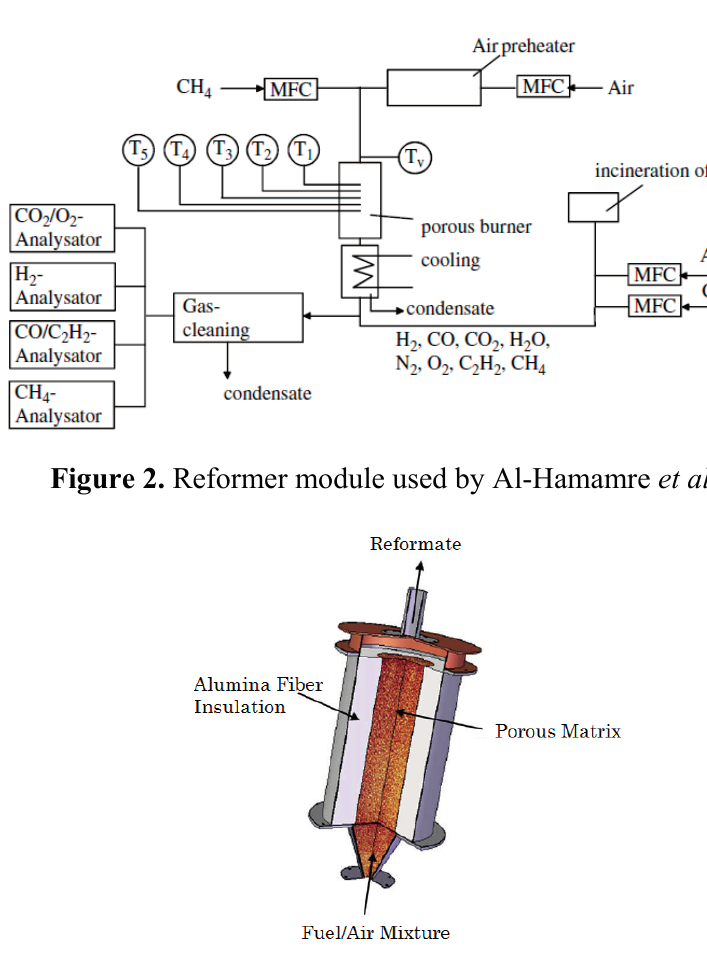
Figure 1. Experimental setup used by Al-Hamamre et al. [8].